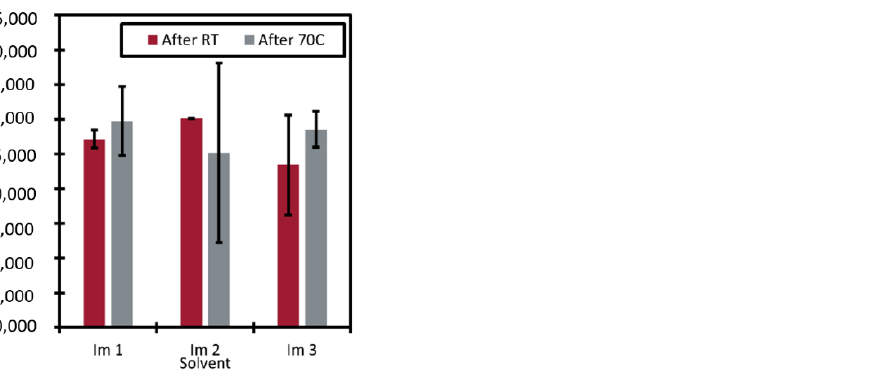
Figure 3. The amount of Im 1, Im 2, and Im 3 solvent that dissolved in the water phase after contact at RT and after phase separation at 70 °C. The error bars represent one standard deviation among at least two trials.